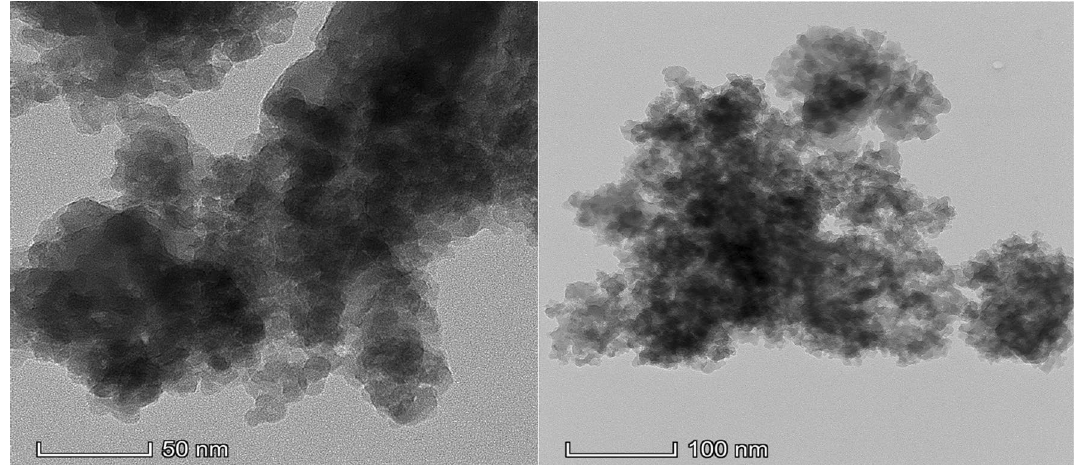
Figure 4. Transmission electron micrographs of silica nanoparticles synthesized from UKMRC-8 rice husk ash, viewed at various resolutions.